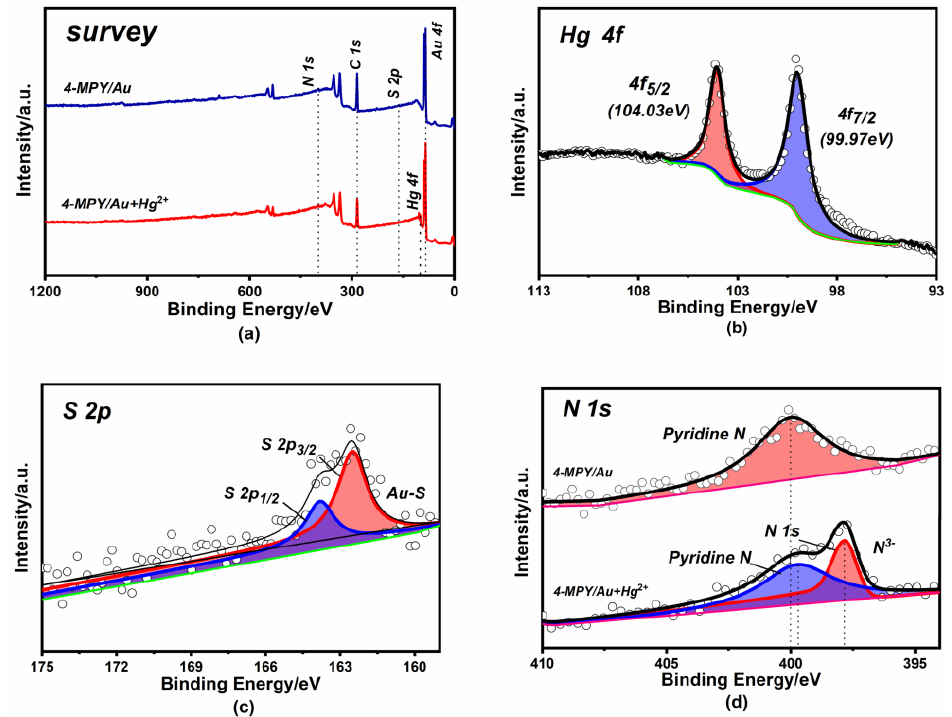
Figure 4. XPS spectra of the modified electrode before and after the reaction with Hg 2+ . ( a ) The sur- vey spectrum; (b) Hg 4f; (c) S 2p; ( d ) N 1s. survey spectrum; ( b ) Hg 4f; ( c ) S 2p; ( d ) N